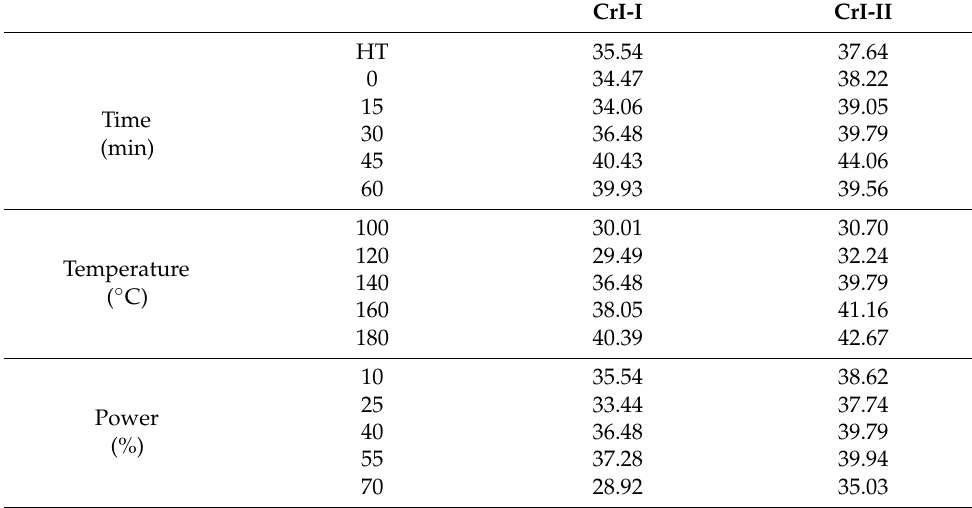
Table 2. Crystallinity of solid